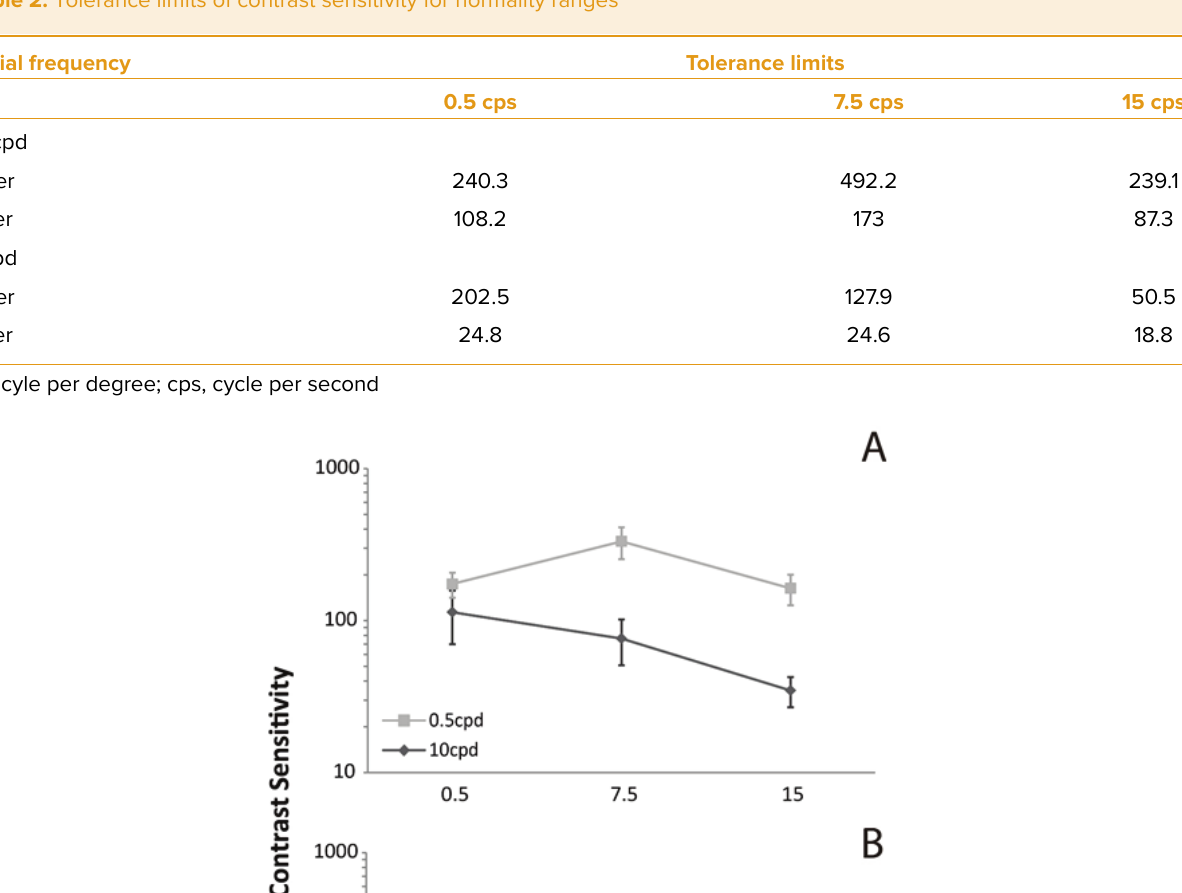
Table 2. Tolerance limits of contrast sensitivity for normality ranges